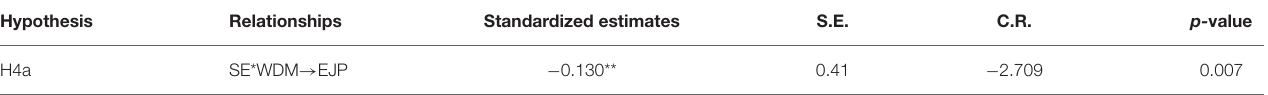
TABLE 4 | Moderating